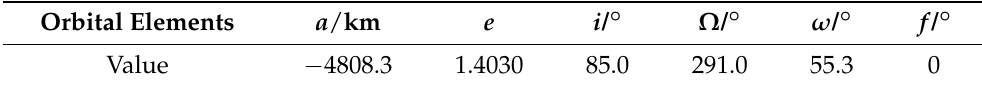
Table 1. Orbital elements at perilune of precise Moon-to-Earth transfer trajectory. Orbital